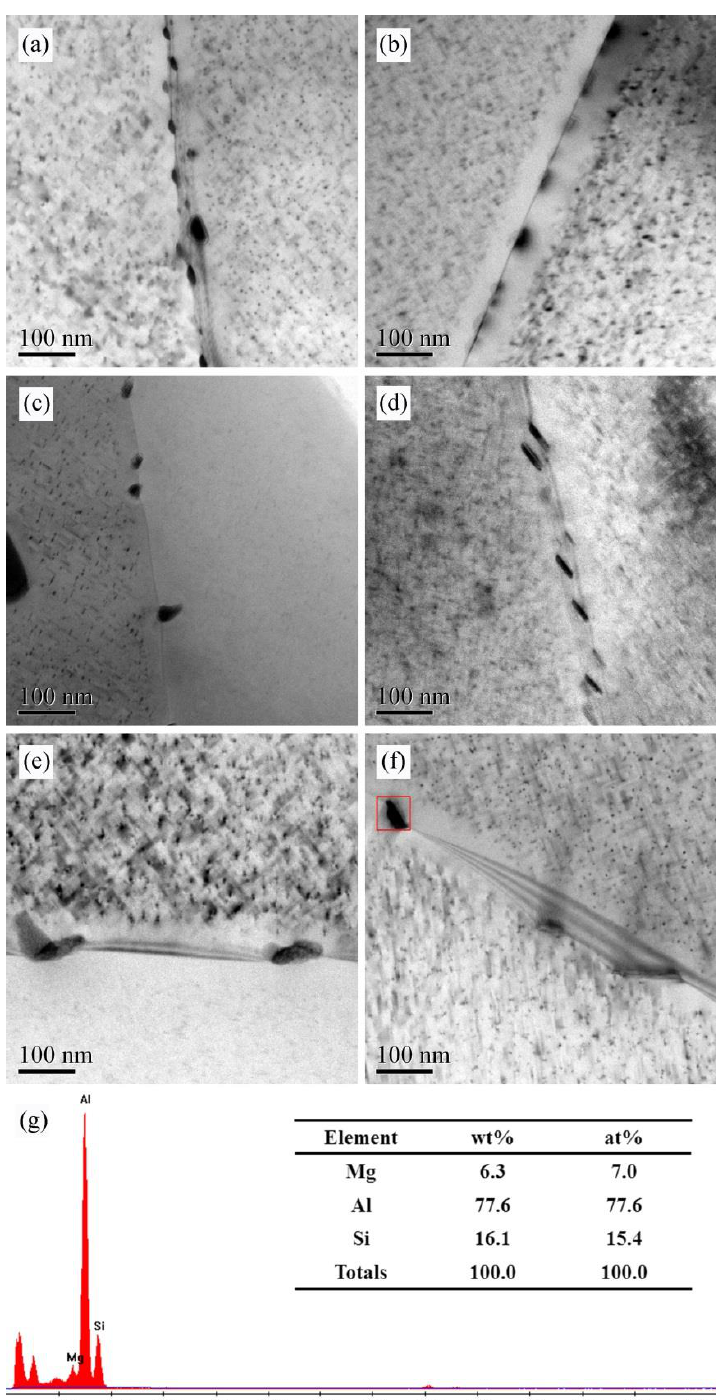
Figure 4. TEM and EDS analysis on grain boundary precipitates of alloy AA and AZ under aging at 170 °C: ( a , c , e ) alloy AA, ( b , d , f ) alloy AZ, ( a , b ) under aged state, ( c , d ) peak aged state, ( e , f ) over aged state, and ( g ) EDS analysis of the precipitates.